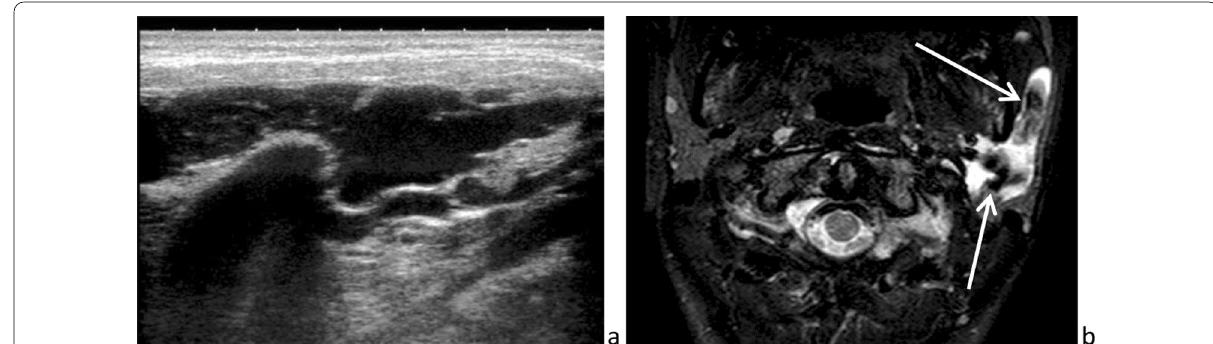
Fig. 10 Venous malformation. Tortuous veins containing phleboliths, on sonography ( a ) and T 2 *‑weighted image ( b